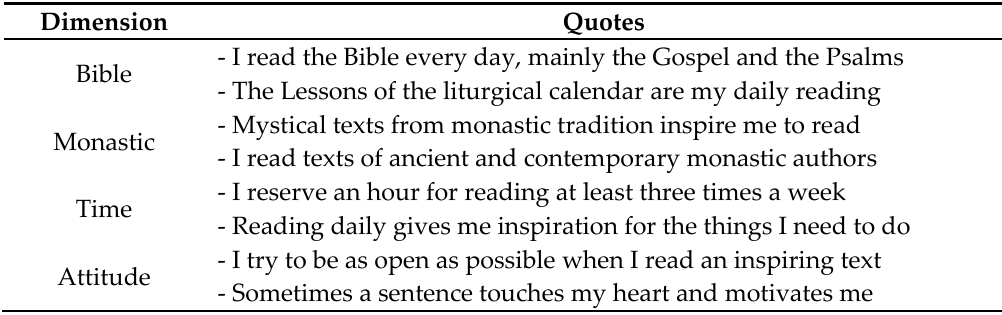
Figure 2. Dimensions of reading—quotes.